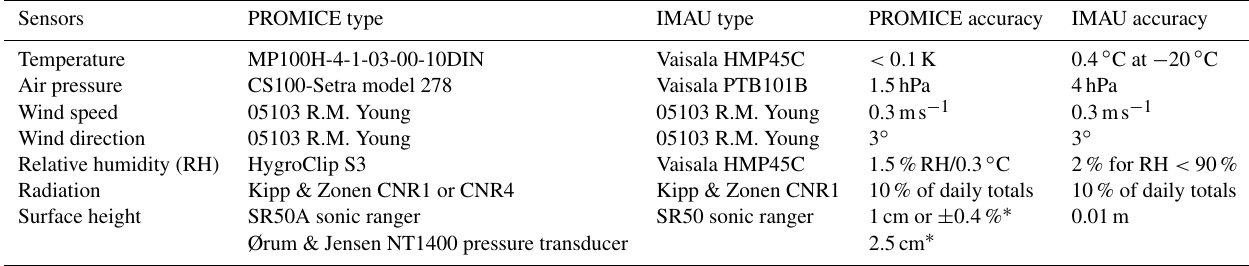
Table 2. AWS sensor specifications. RH signifies relative humidity.